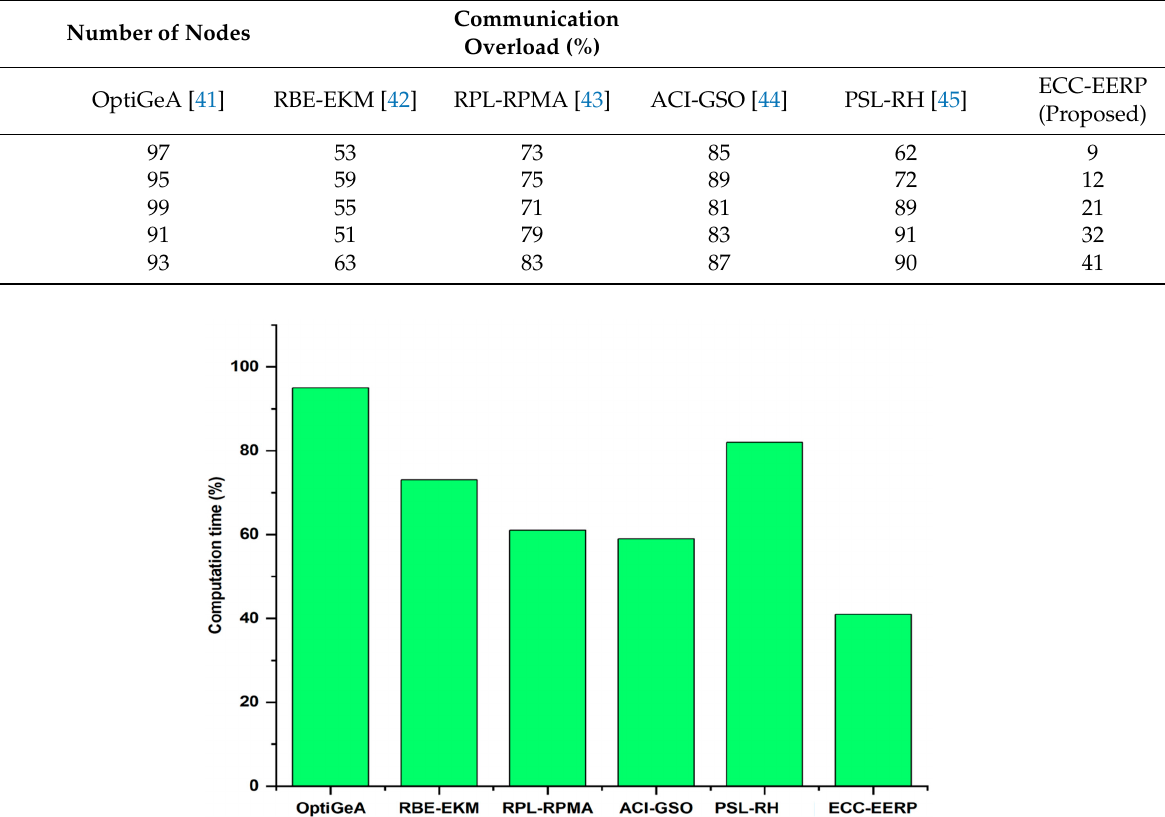
Figure 8. Communication overload of the proposed and existing methods [41–45]. Table 7. Communication overload of the proposed and existing methods.